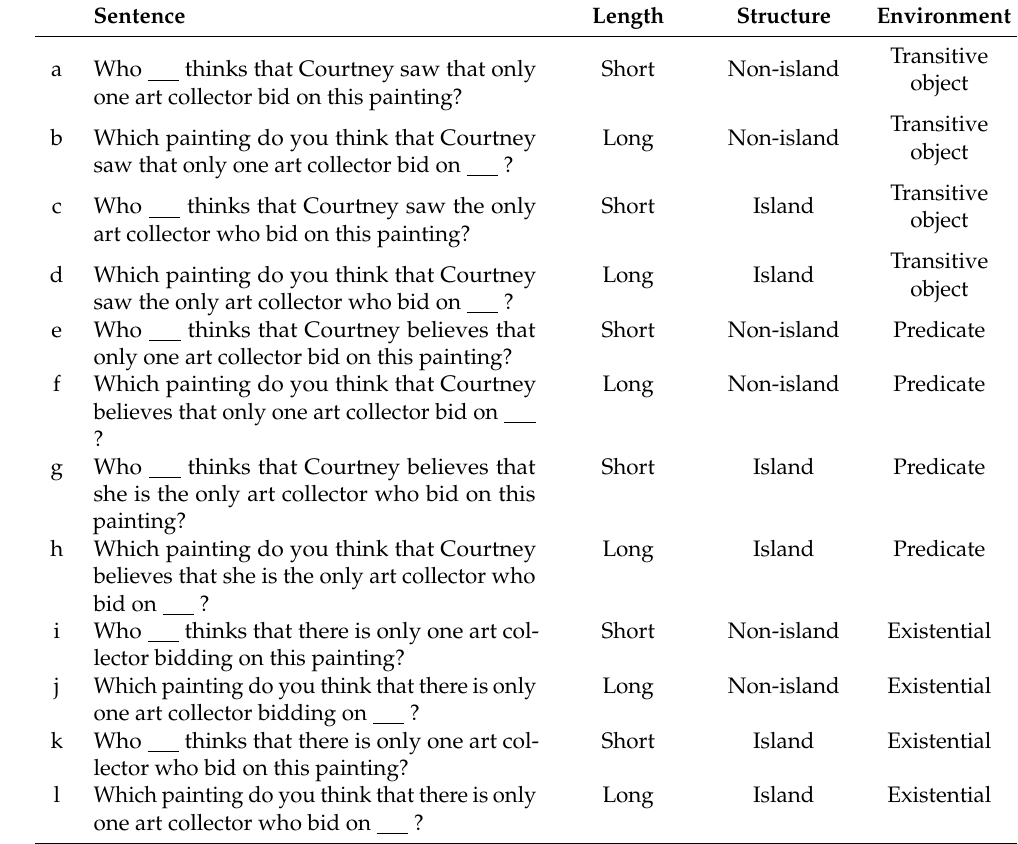
Table 1. Experiment 1 sample